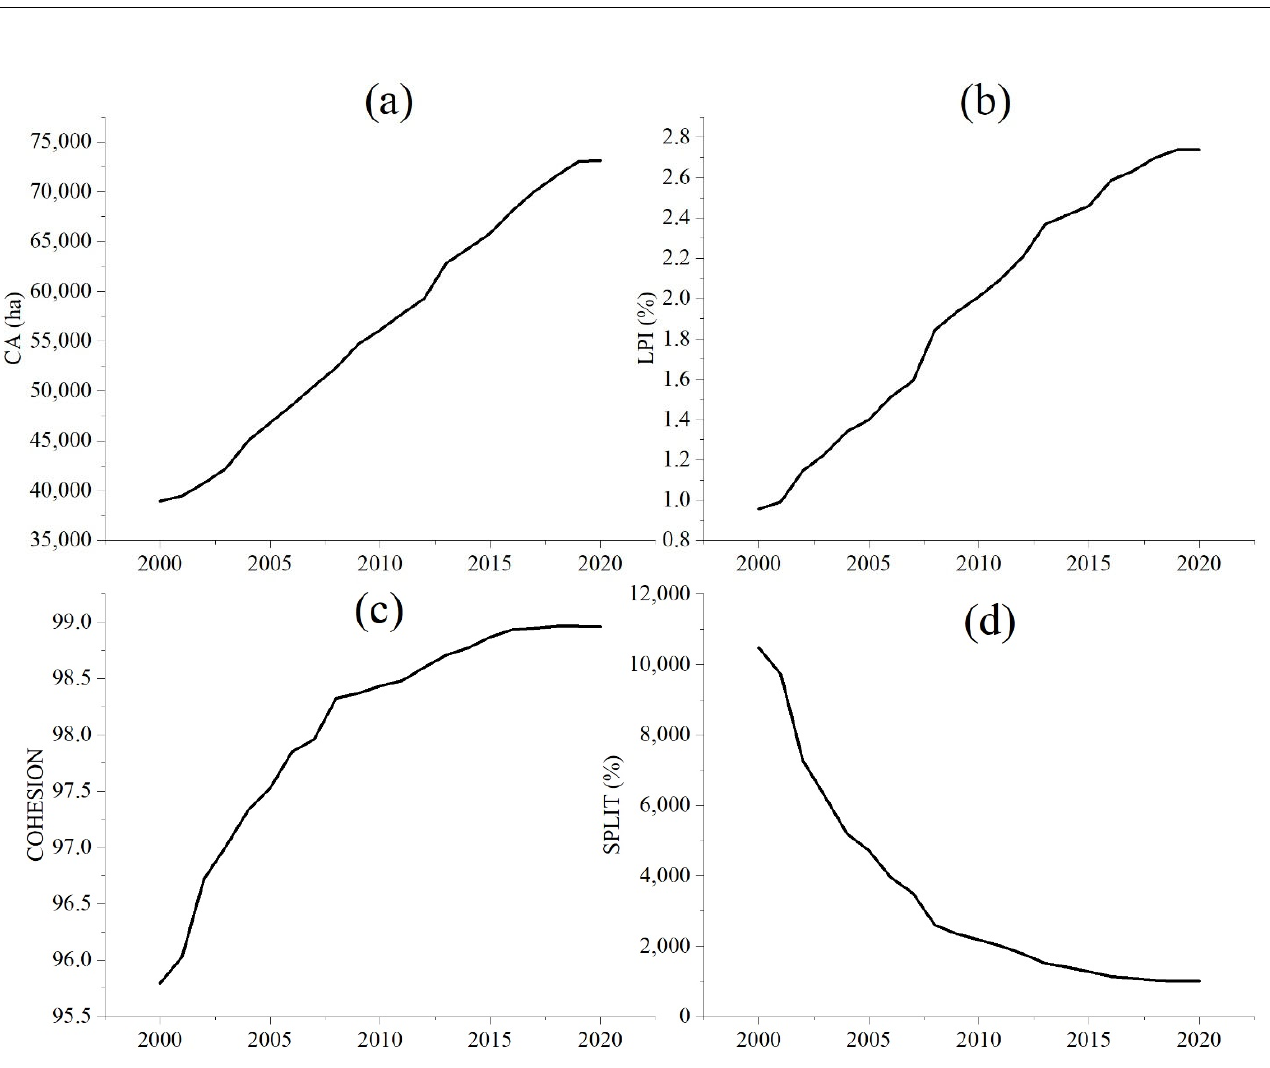
Figure 10. Changes in urban landscape pattern index. ( a ) urban landscape area; ( b ) the Largest Path Index (LPI) of urban patches; ( c ) the Patch Cohesion Index (COHESION) of urban; ( d ) Splitting Index (SPLIT) of urban. Table 4. Regression coefficient of LPI with GDP, GDP per capita and fixed investment (R square is 0.99).